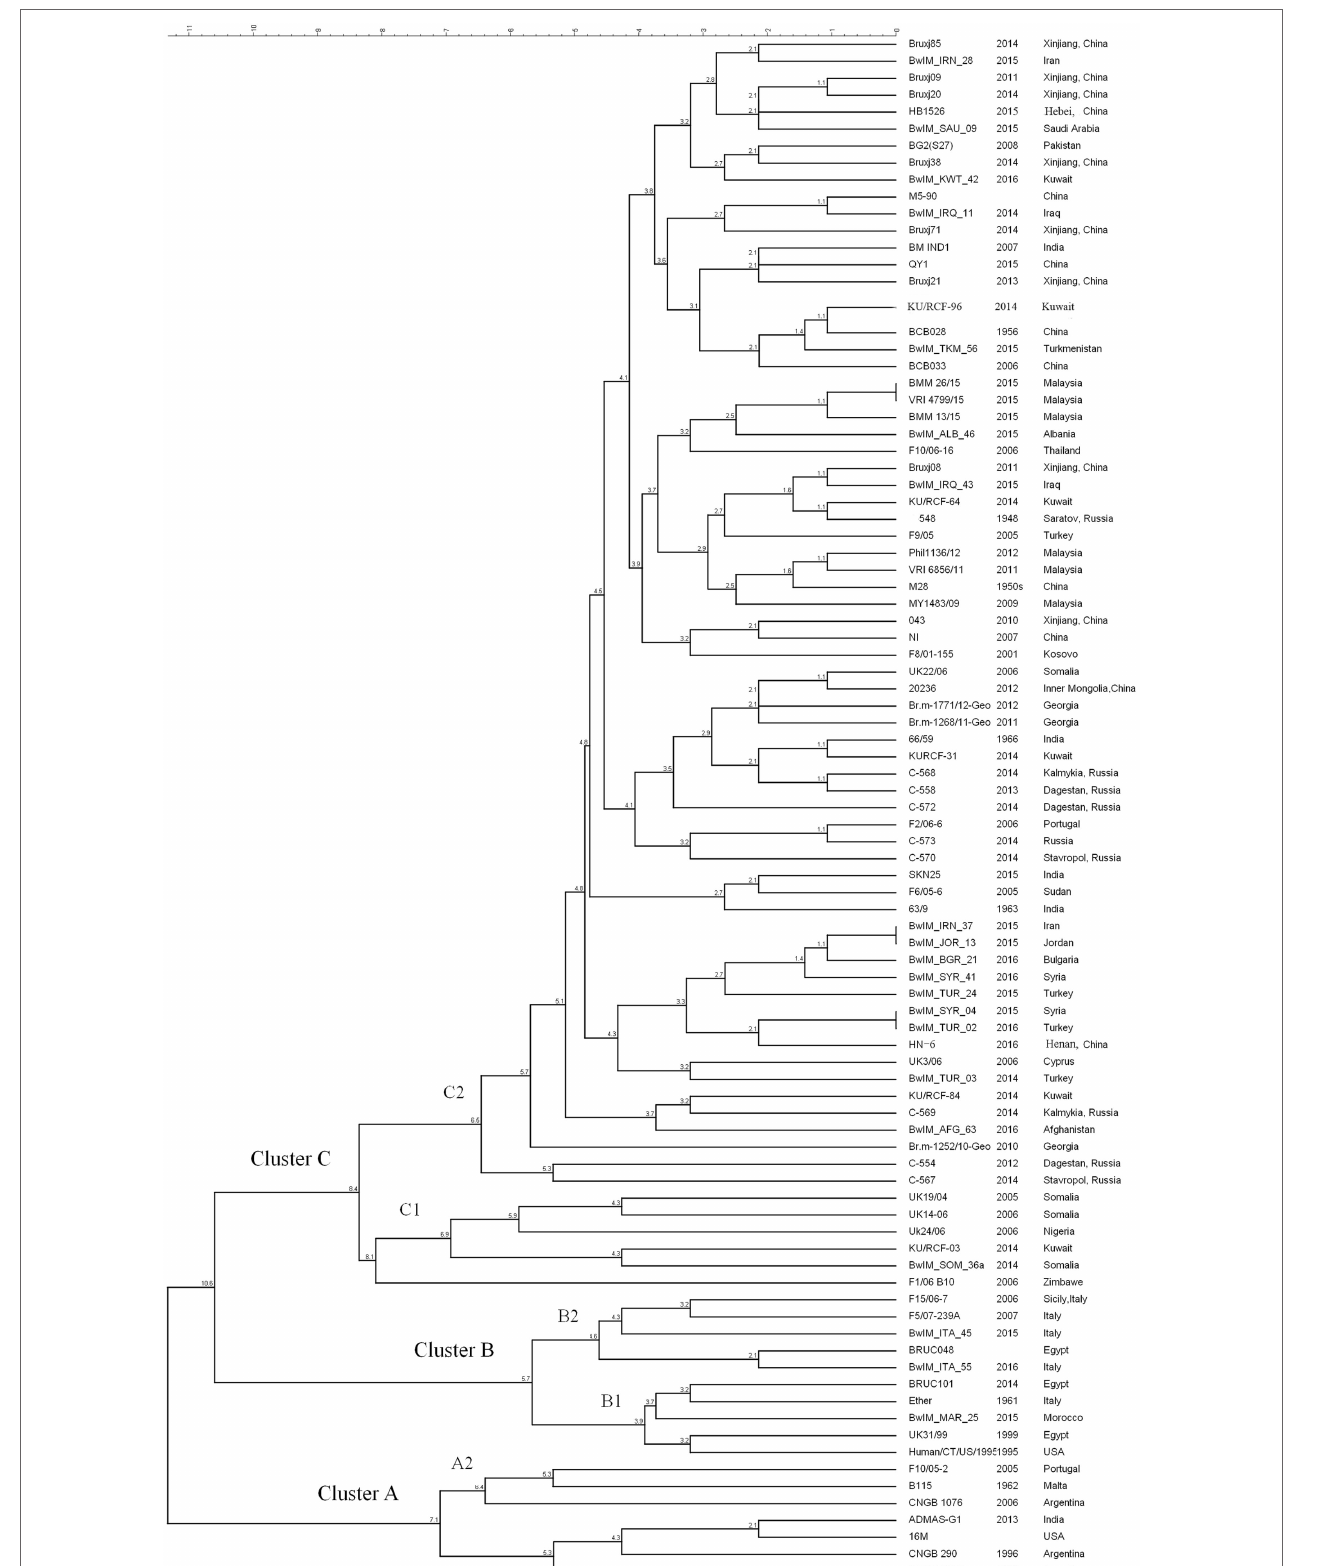
FigUre 4 | MLVA-16 clustering analysis of 90 Brucella melitensis strains including 81 strains selected from NCBI database and 9 strains used in this